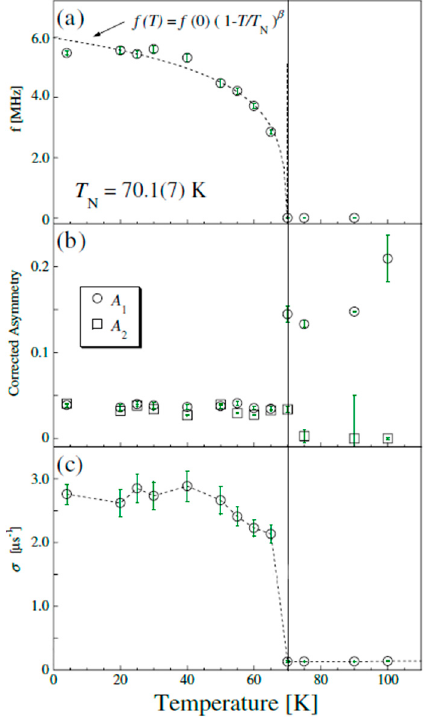
Figure 8. Temperature dependence of fit parameters from ZF- μ SR of Cu